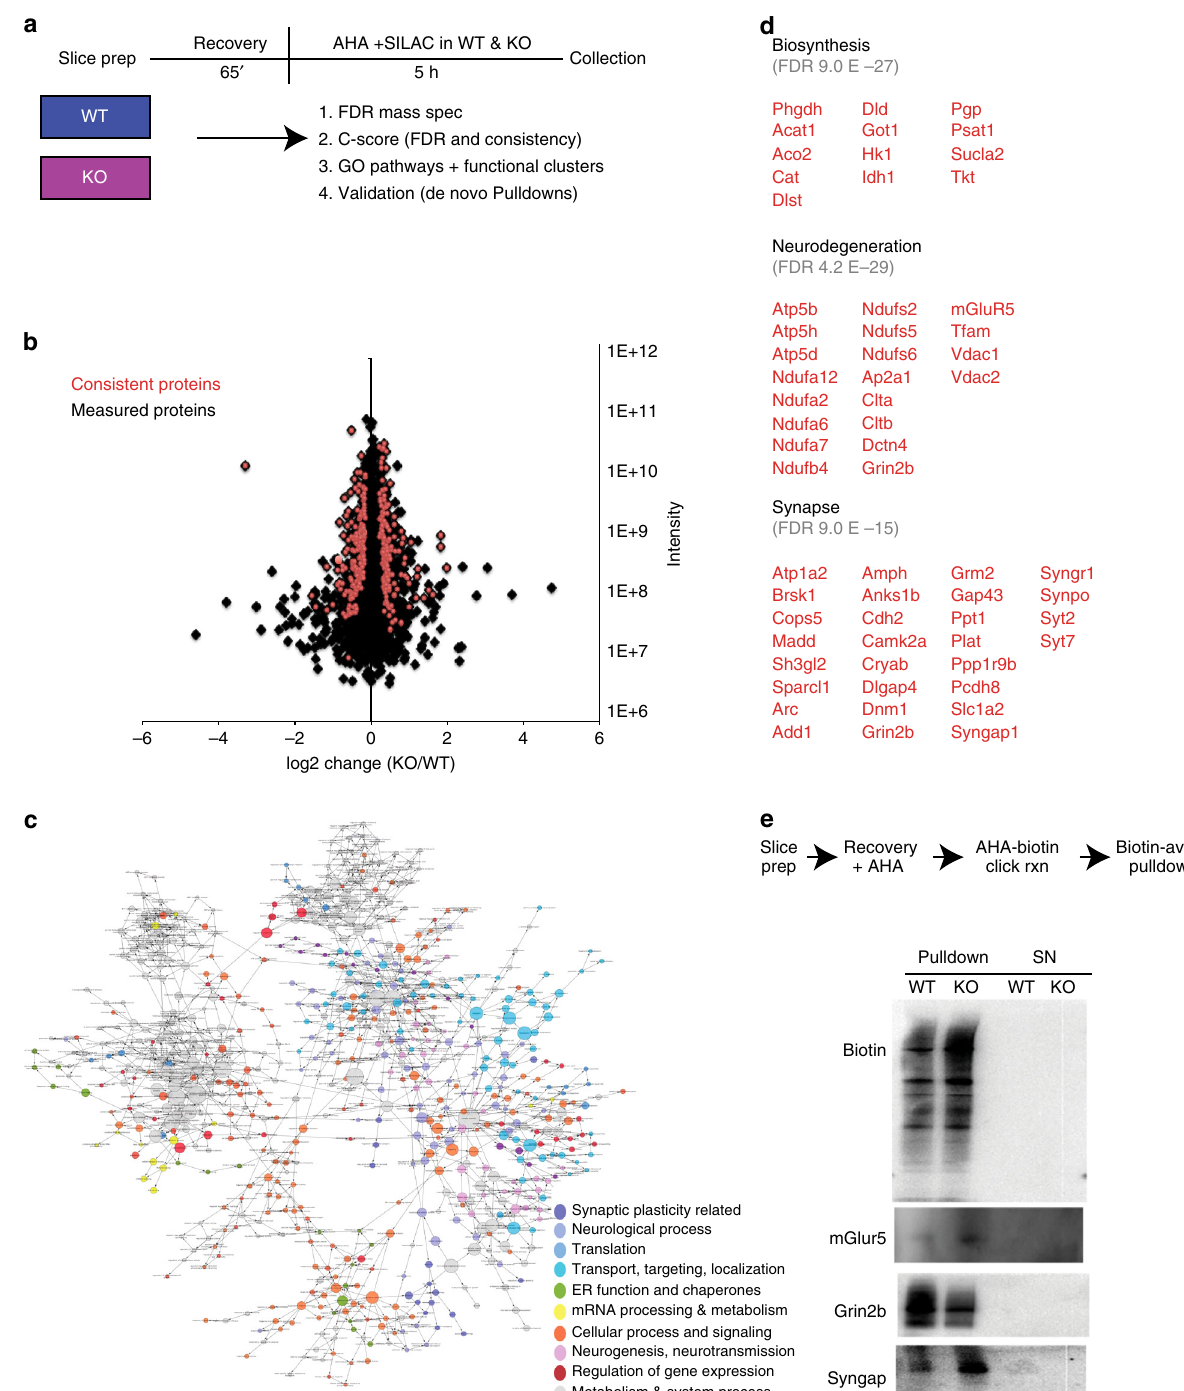
Fig. 1 Steady state de novo proteome in the hippocampus of wild-type and Fmr1 knockout mice. a Schematic timeline and work fl ow of the BONLAC experiment in hippocampal slices from wild-type (WT) and Fmr1 knockout (KO) mice. Data are from 3 biological replicate experiments ( n = 3 mice/ treatment/experiment for 3 separate experiments, therefore n = 9/genotype split pooled into groups of 3). b Fold change vs intensity distribution plot of all detected proteins in KO versus WT hippocampal proteome in black. Overlay with red scatter plot depicts candidate proteins that were consistently altered using cut-offs derived from C-score rank score algorithm. c BinGO Cytoscape depiction of enriched gene ontology groups. d Top functional clusters in Fmr1 KO mice compared to WT littermates using DAVID 6.8. e AHA-pull down validations ( n = 3 mice per genotype in WT/KO